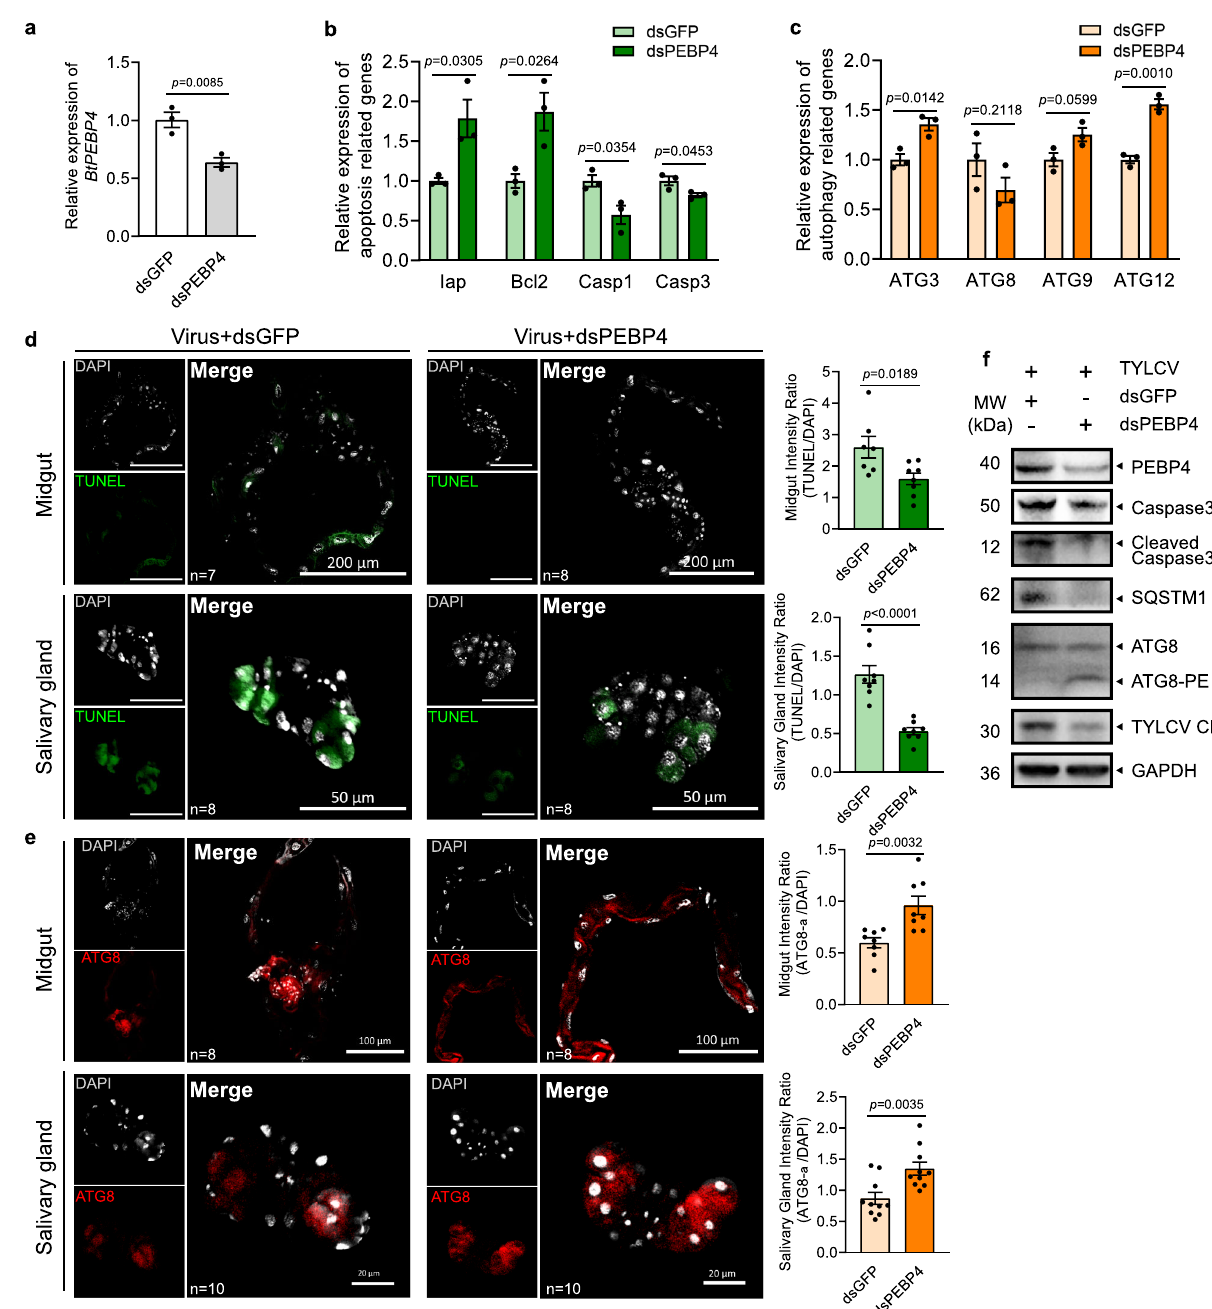
Fig. 3 Knockdown of PEBP4 attenuated TYLCV-induced apoptosis but enhanced autophagy. a BtPEBP4 RNAi knockdown in white fl y reduced the expression of BtPEBP4 at mRNA level, and dsGFP served as control. b The relative expression of apoptotic related genes ( Iap , Bcl2 , Caspase1 , Caspase3 ), and c autophagy related genes ( ATG3 , ATG8 , ATG9 , ATG12 ) were determined using qPCR. Three independent samples were used for each treatment. All data were checked for normality by the Wilk-Shapiro test. Two-sided paired t- test was used to separate the means of normally distributed data, while Mann – Whitney test was used to analyze nonparametric distributed data, no multiple comparisons were performed in each test. d Apoptosis in midgut and salivary gland was determined by TUNEL labeling (green). e Autophagy was noted by ATG8-PE (red), and nuclei were stained by DAPI (white). Sample sizes ( n ) for statistical tests indicated in the panels refer to biologically independent white fl y. Relative intensity was quanti fi ed by ImageJ. Values in bar plots represent mean ± SEM. f Immunoblotting using whole body. GAPDH served as the loading control, and three independent biological replicates were